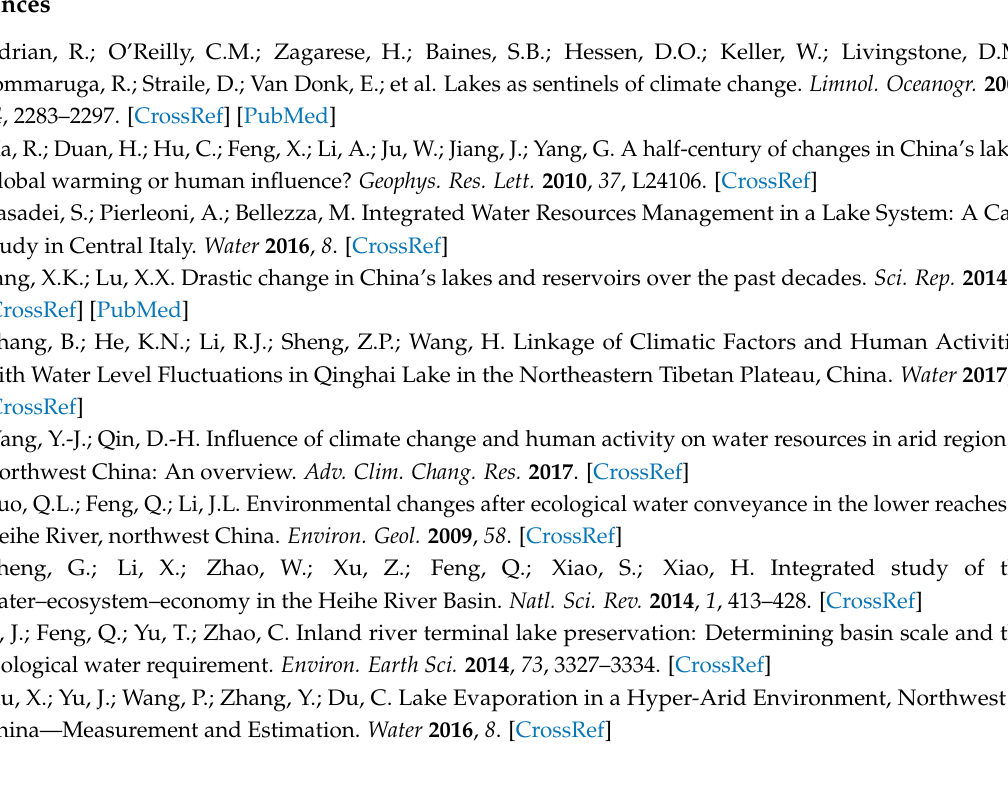
Figure S1: The monthly variation in mean annual meteorological variables included precipitation ( P , mm), Figure S2: The relationship between net radiation ( R n , MJ · m − 2 · day − 1 ) calculated by the Penman–Monteith model (Equation (8)) and R n of pan ( R n , Pan , MJ · m − 2 · day − 1 ) calculated by the original PenPan model (Equations (3)–(6)) from 1957 to 2016, Figure S3: The relationship between lake elevation (m) and area ( A L , km 2 ) and storage ( S , million m 3 ) of Juyan Lake, as surveyed by the Wuhai Hydrographic and Water Resources Survey Bureau, Inner Mongolia, China, in 2003, Figure S4: The time series of ten-days measured (a) lake storage ( S , mm) and area ( A L , km 2 ), (b) change of S (mm) and surface runoff ( Q s , mm) for Juyan Lake, and (c) observed pan evaporation ( E p , mm) by the E601 (Obs) and calculated by the modified PenPan model (Cal) from 2002 to